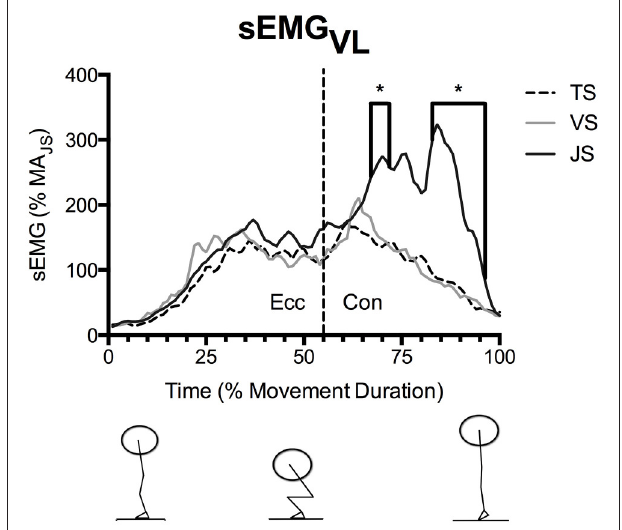
FIGURE 4 | Mean vastus lateralis EMG (sEMG VL ) during parallel-depth slow-tempo (TS), volitional speed (VS), and jump (JS) squat conditions ( n = 10). Values are presented as a percentage of muscle activity during an unloaded jump squat. *Indicates significant difference between TS and JS. Range of SEM at 20, 40, 60, 80, and 100% movement duration is 11.7–84.8% activity of the unloaded jump